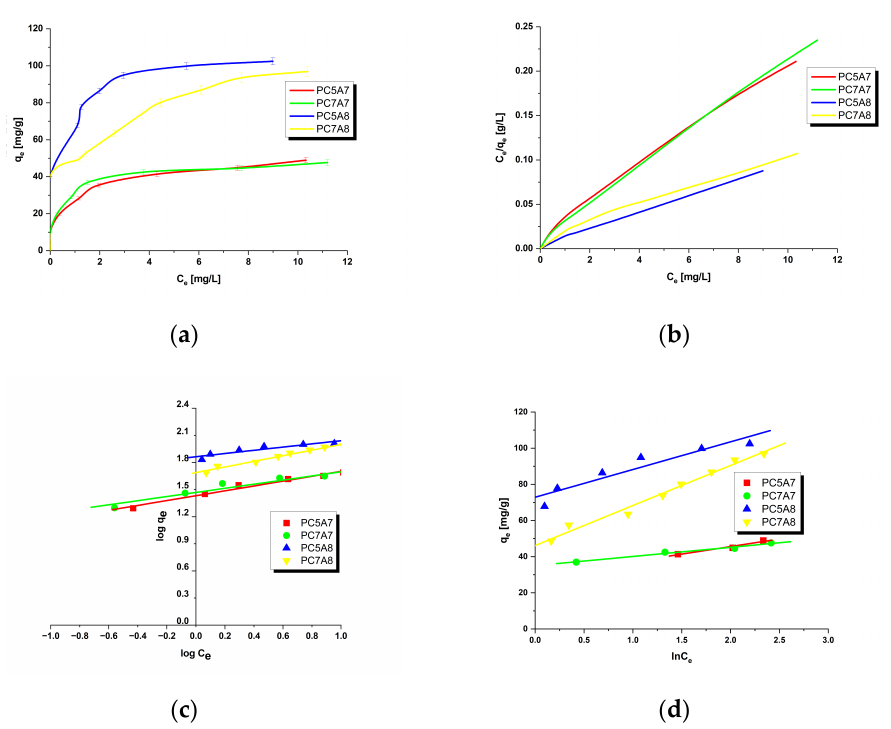
Figure 1. Adsorption of methyl red onto activated carbons ( a ) equilibrium adsorption of the dye, ( b ) Langmuir isotherm plots, ( c ) Freundlich isotherm plots and ( d ) Temkin isotherm plots.